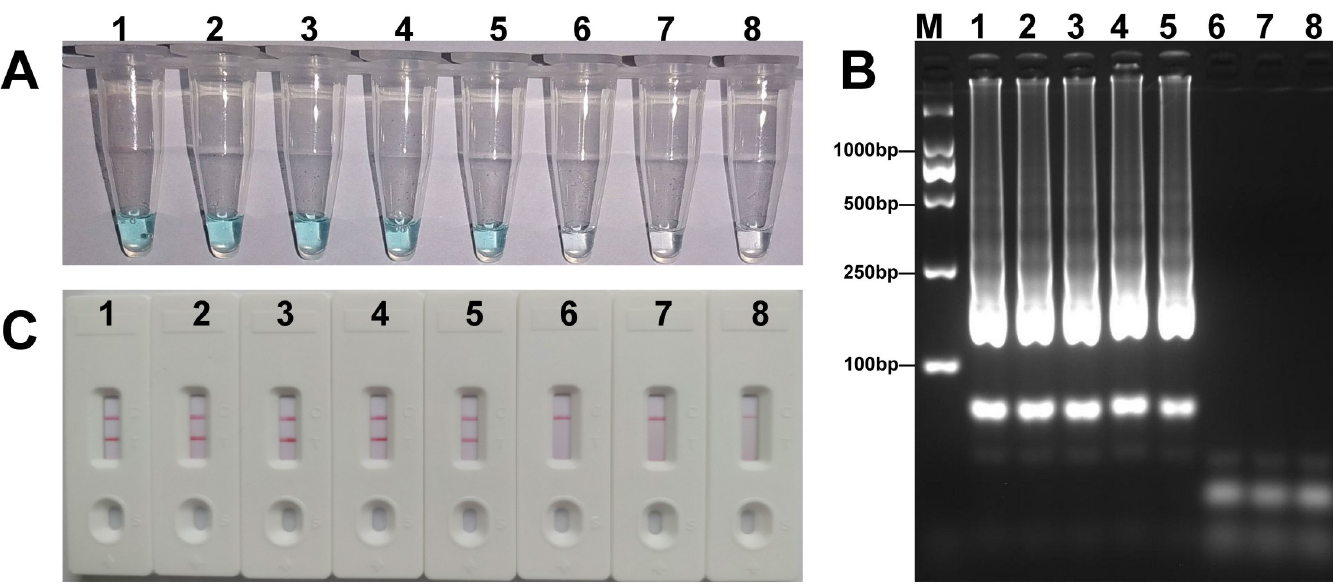
Fig 4. Sensitivity of the mcr-1 -LAMP-LFB assay. Tubes (A)/lanes (B)/biosensors (C) 1–6 represented the levels of plasmid DNA ( E . coli WHCDC128) 3.6 ng, 360 pg, 36 pg, 3.6 pg, 360 fg and 36 fg per reaction, respectively. Tubes (A)/lanes (B)/biosensors (C) 7 and 8 represented the negative (KPC-2-producing E . coli WHCDC332) and blank controls (nuclease-free water), respectively.